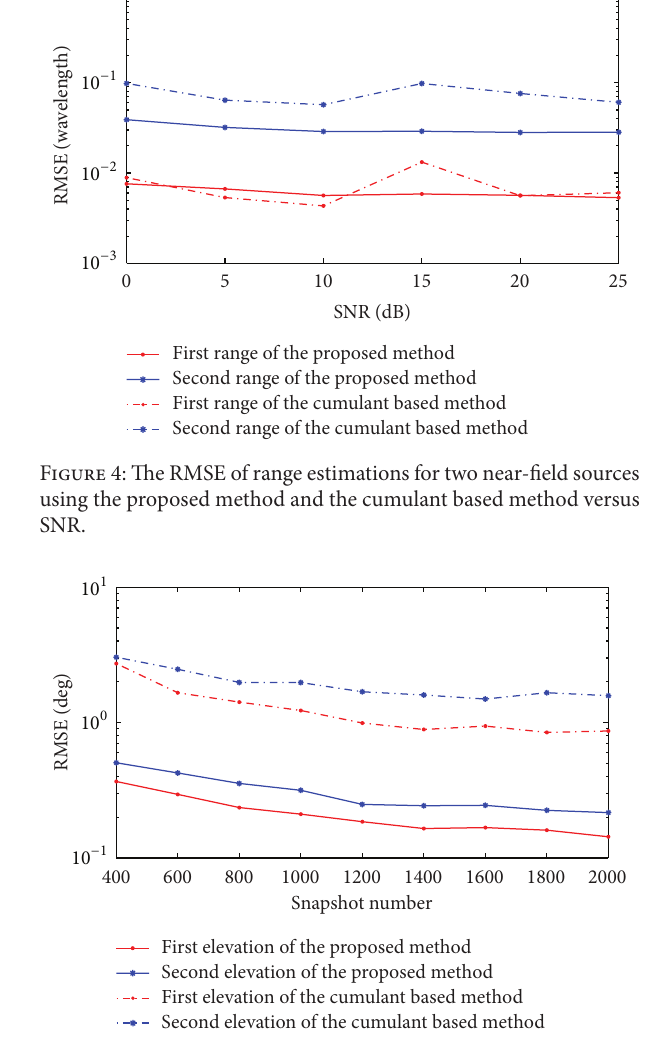
Figure 5: The RMSE of elevation estimations for two near-field sourcesusingtheproposedmethodandthecumulantbasedmethod versus snapshot